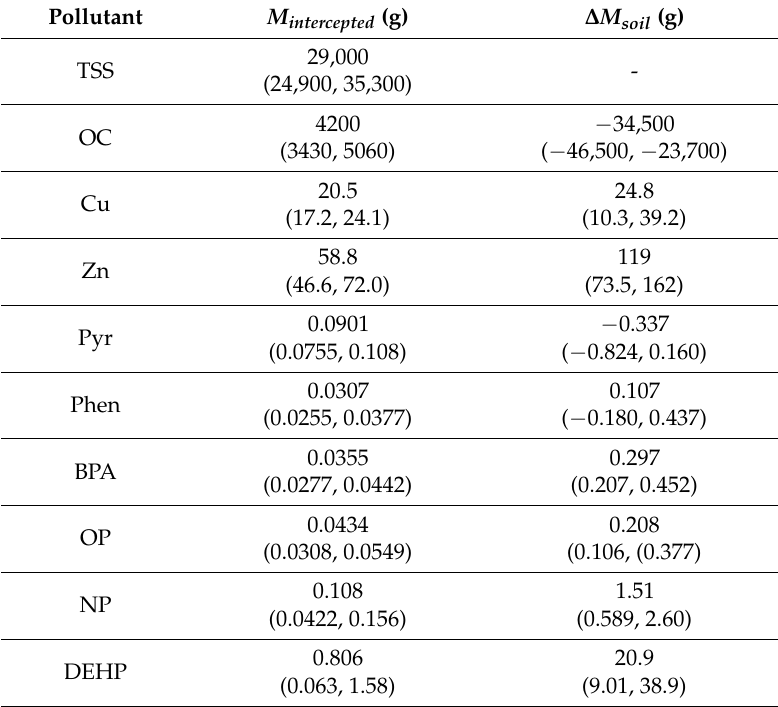
Table A7. Net mass balance terms associated with water fluxes (difference between mass entering and exiting the system– M intercepted ) and soil (difference between initial and final masses stored in soil– ∆ M soil